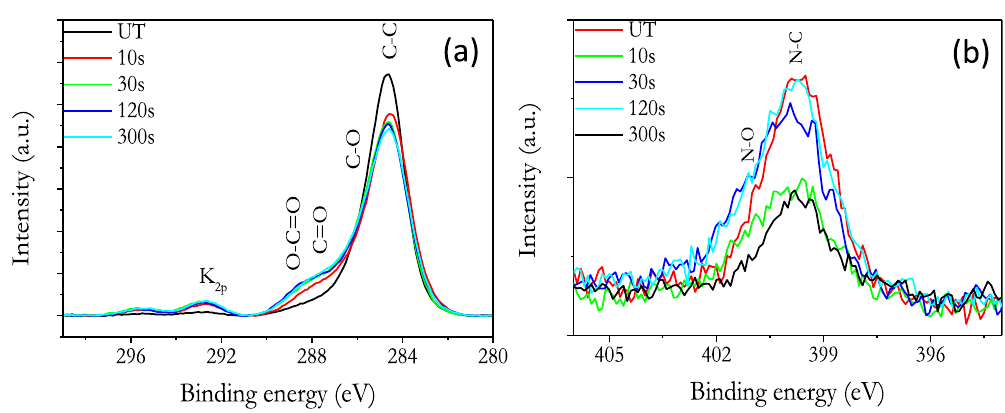
Figure 8. XPS high resolution C 1s /K 2p ( a ) and N 1s ( b ) spectra corresponding to untreated and plasma treated nasturtium